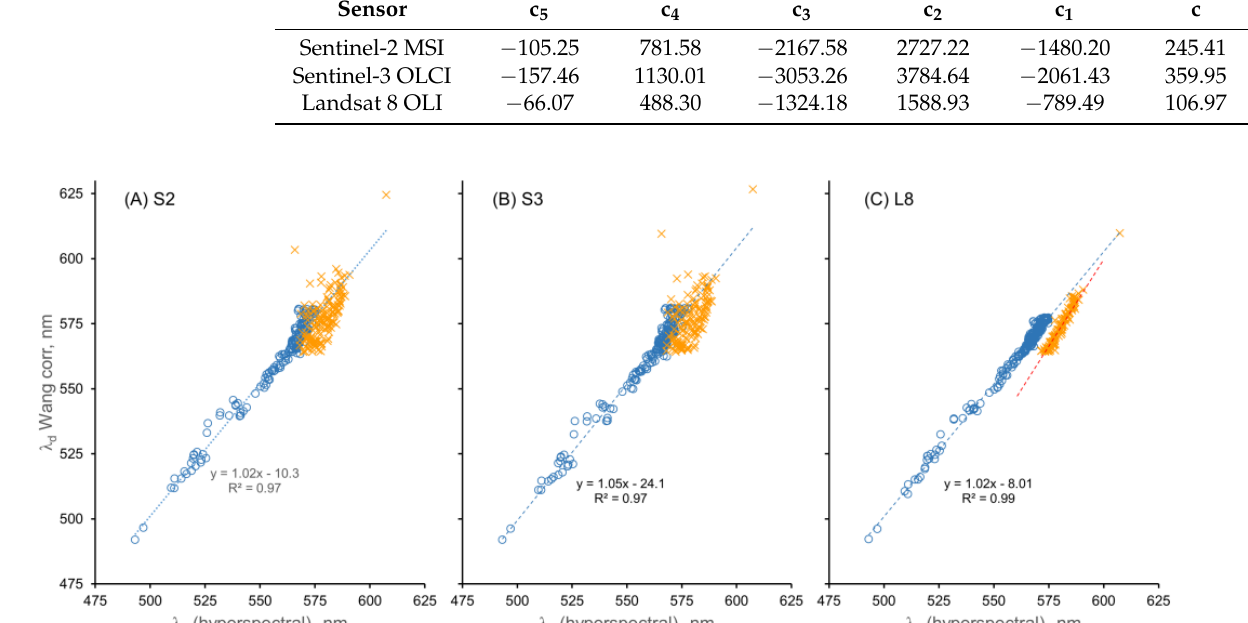
Figure 7. Calculated λ d values using the Wang method versus λ d,hyp after α correction for the three sensors. The blue circles represent data points where hue angle was corrected; the orange ( × ) data points represent values where corrections were not applied.